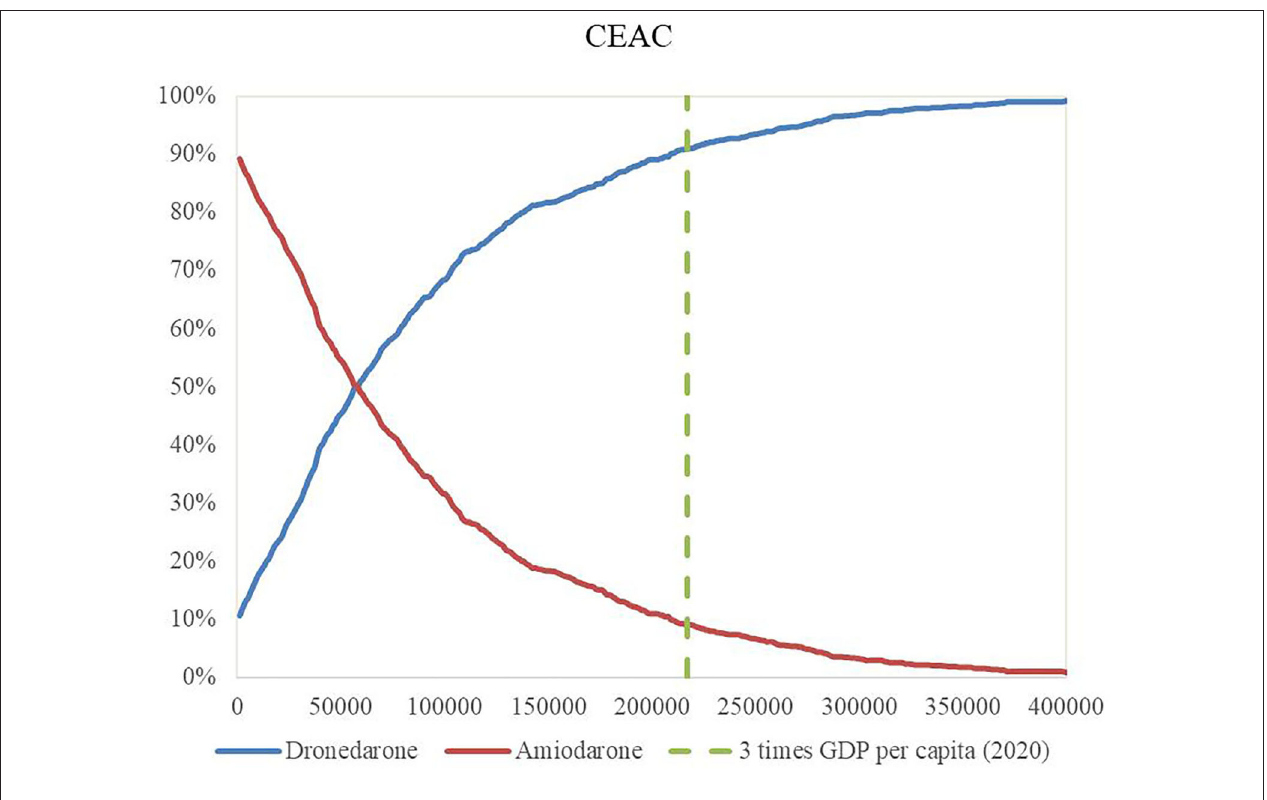
FIGURE 5 | Cost-effectiveness acceptability curve.